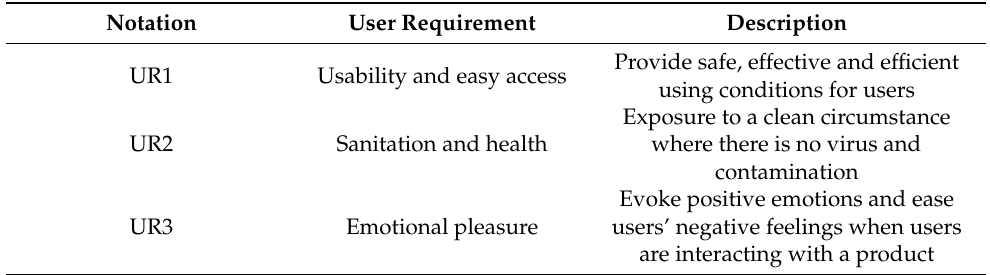
Table 4. User requirements (URs) of urban furniture design for pandemic prevention and